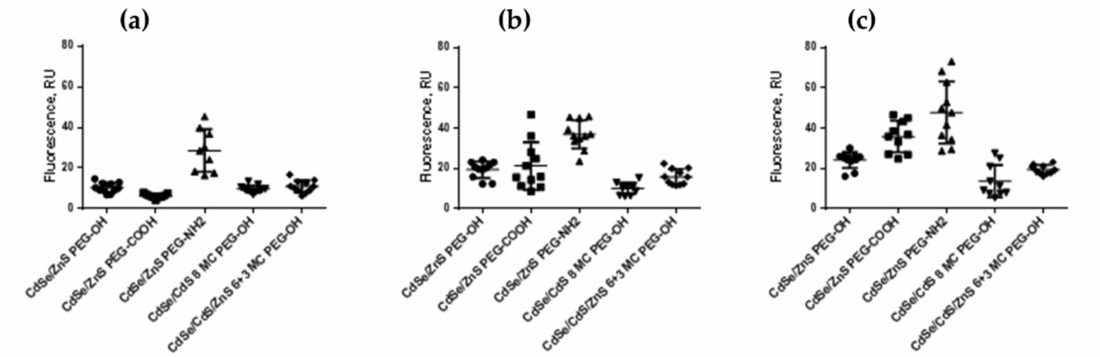
Figure 9. The intensity of fluorescence of SK-BR-3 cells incubated in the presence of QDs with different sizes and charges for (a) 24 h, (b) 48 h, and (c) 72